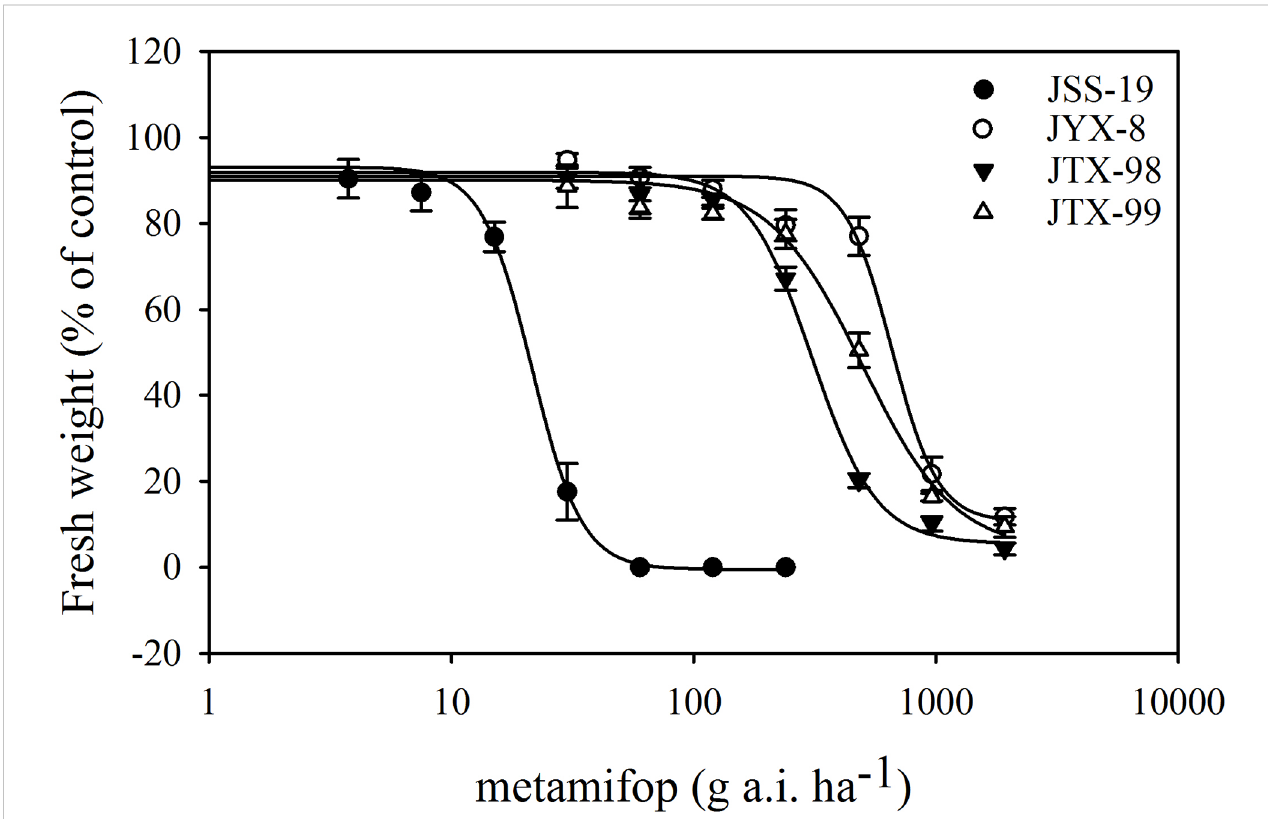
FIGURE 1 Dose response curves for four populations of D . ciliaris var. chrysoblephara to metamifop generated from dose response experiments. A log-logistic model was used to analyze the test data (the fresh weight percentage of the control). The GR 50 values of resistant populations (JYX-8, JTX-98, and JTX- 99) were signi fi cantly higher than in the sensitive population JSS-19. Vertical bars indicate standard